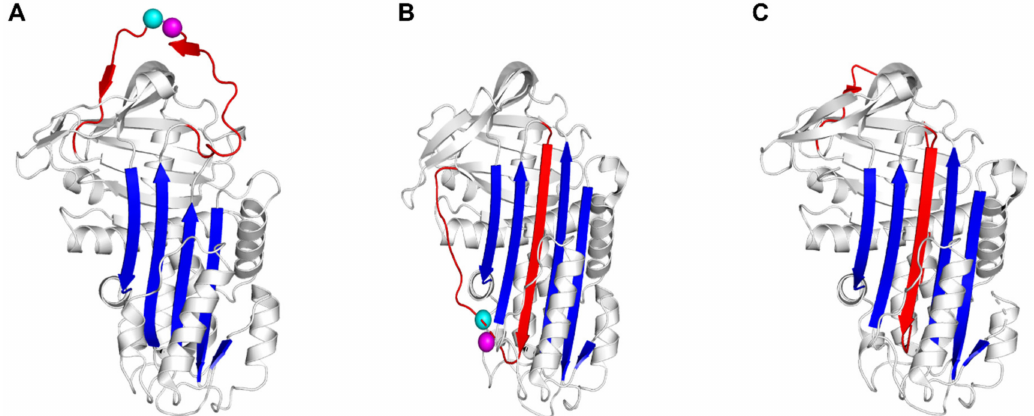
Figure 1. Cartoon representations of the structures of plasminogen activator inhibitor-1 (PAI-1) in the active ( A ), latent ( B ), or cleaved ( C ) conformation. PAI-1 is shown in white, the central PAI-1 β -sheet A in blue; the flexible reactive center loop (RCL) in red, and Arg346 and Met347 (P1–P1 (cid:48) ) of the reactive center are indicated by magenta and cyan spheres, respectively. In latent ( B ) and cleaved ( C ) PAI-1, the N-terminal part of the RCL is inserted into the central PAI-1 β -sheet A to become strand 4 (s4A, shown in red). Protein Data Bank entries 1DB2 [11], 1DVN [12], and 3EOX [13] were used to generate this